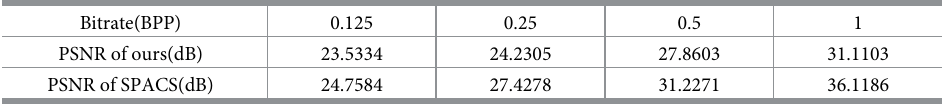
Table 3. Comparison with SPACS